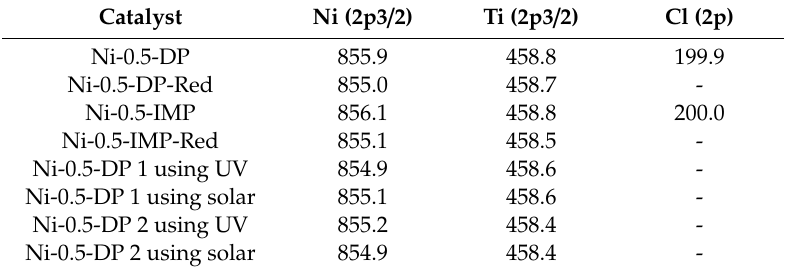
Table 3. Ni (2p3 / 2), Ti (2p3 / 2) and Cl (2p) binding energies (eV) as determined by